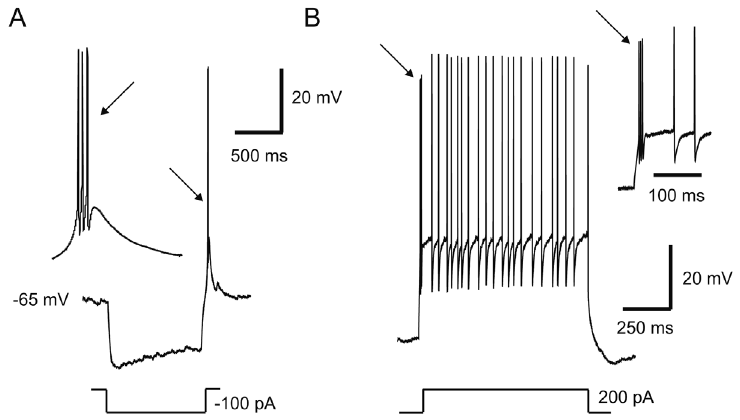
Figure 1 Low-voltage activated (T-type) calcium channels contribute to burst firing in thalamocortical neurons. Panel (A) shows the characteristic burst-firing phenotype of thalamocortical relay neurons. Hyperpolarization activates low-voltage activated (LVA, T-type) calcium channels, which when released from hyperpolarization result in a burst of high-frequency action potentials (arrows) that ride on a low-threshold calcium spike (LTS). (B) Thalamocortical relay neurons show bistable discharge patterns. Following rapid depolarization of the membrane for rest, thalamocortical relay neurons display the characteristic burst phenotype (arrows) before switching to a more regular firing mode. (R. Wijesinghe and A.J. Camp, unpublished